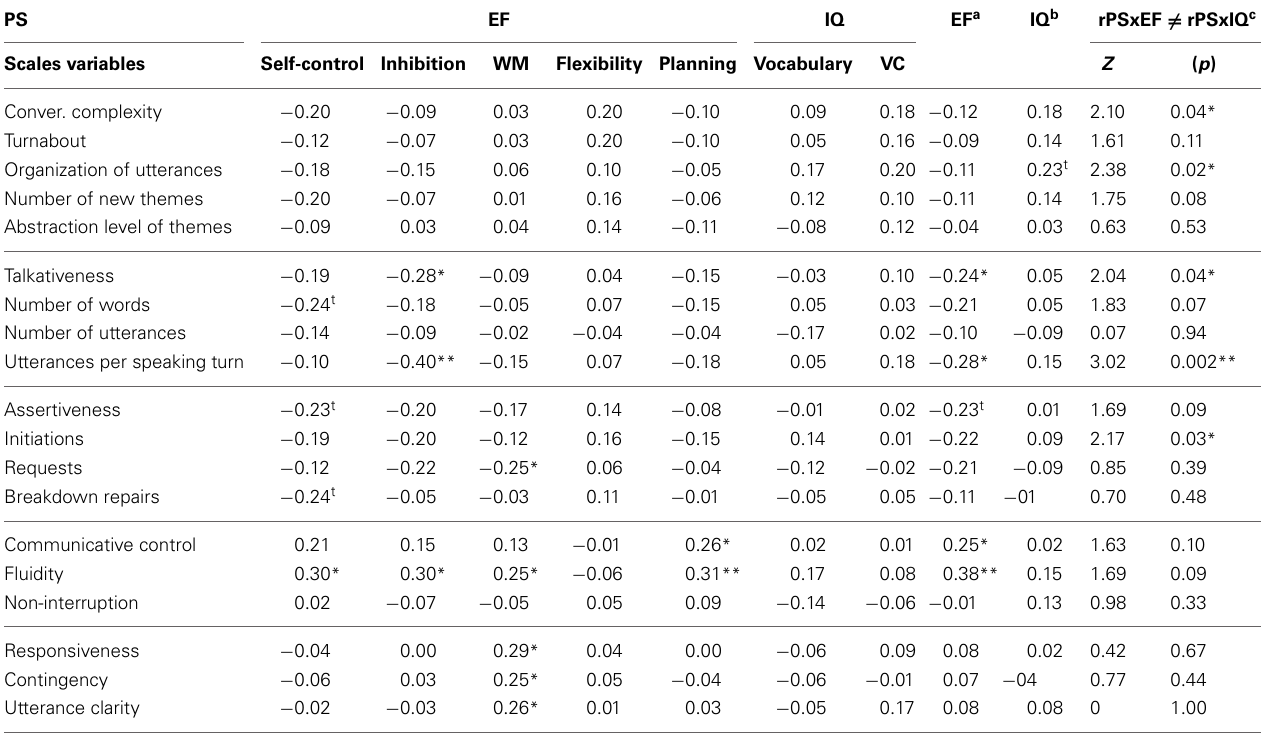
Table 4 | Pearson correlations between pragmatic skills (PS) and executive functions (EF) and between PS and intellectual quotient (IQ); and results of the test of differences between the correlation coefficients for the two relationships. PS EF IQ EF a IQ b rPSxEF (cid:2)= rPSxIQ c